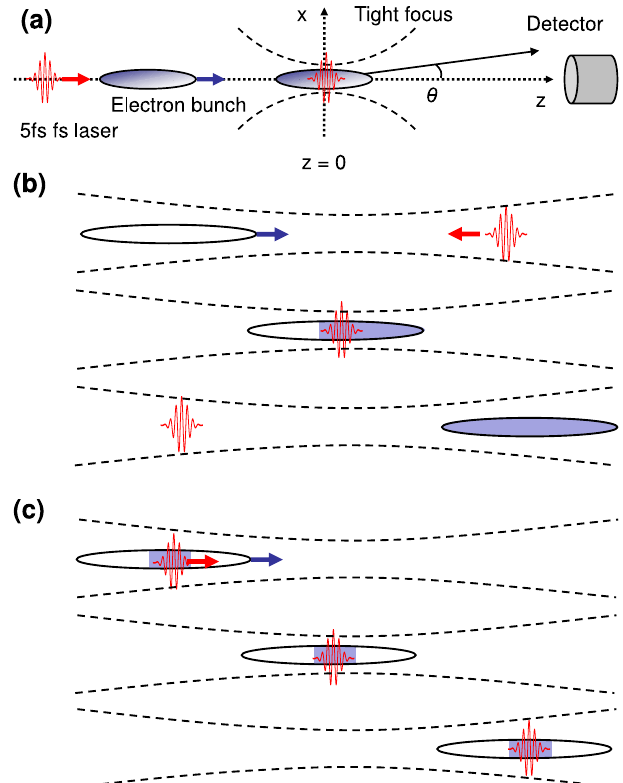
FIG. 2. (a) Schematic diagram of the interaction of a femto- second laser copropagating with an electron bunch. Both the laser and the electron bunch propagate along the þ z direction. z ¼ 0 is defined to be at the best focus of the laser. The detector is located far away in the þ z direction on the axis ( (cid:2) ¼ 0 ). (b), (c) The changes of the position of the electron bunch, the laser pulse, and the focused region (b) in the counterpropagating interaction and (c) in the copropagating interaction. The filled parts of the electron bunch indicate the part that is or has interacted with the strong laser